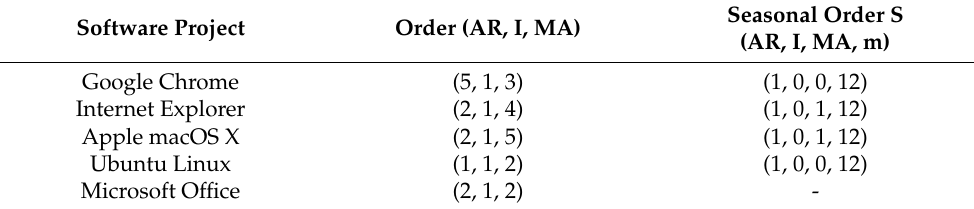
Table 6. Optimal parameters for ARIMA